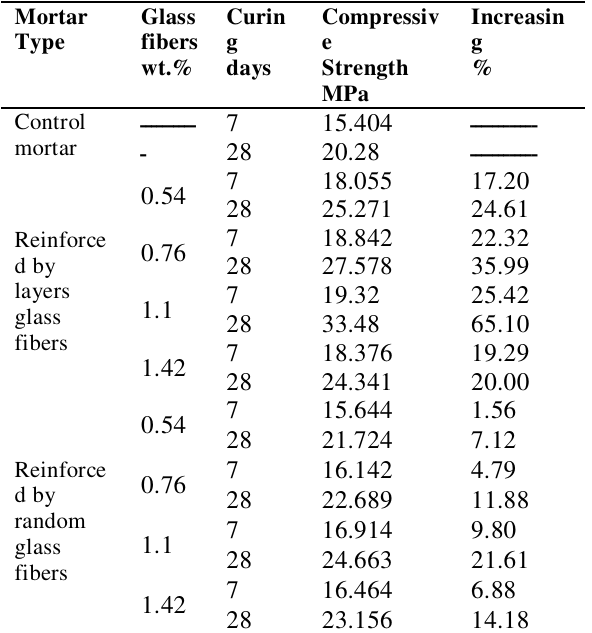
Results of compressive strength testing for glass fibers reinforced mortar without SBR